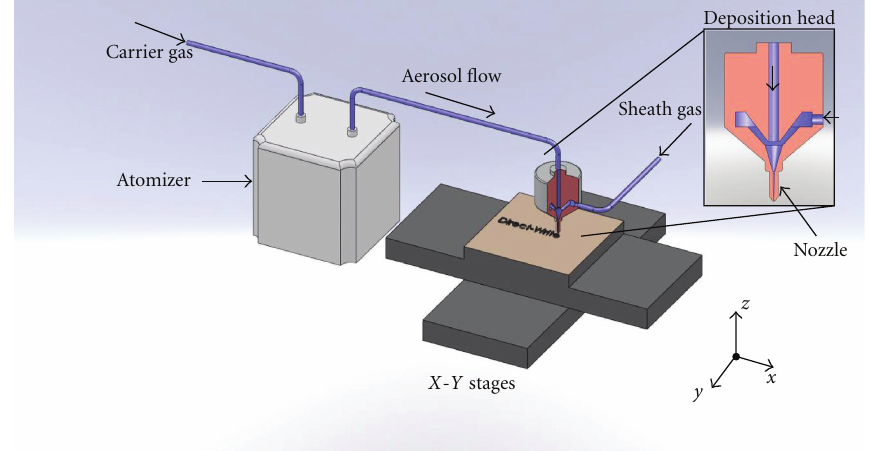
Figure 1: Diagram of Aerosol Jet system.